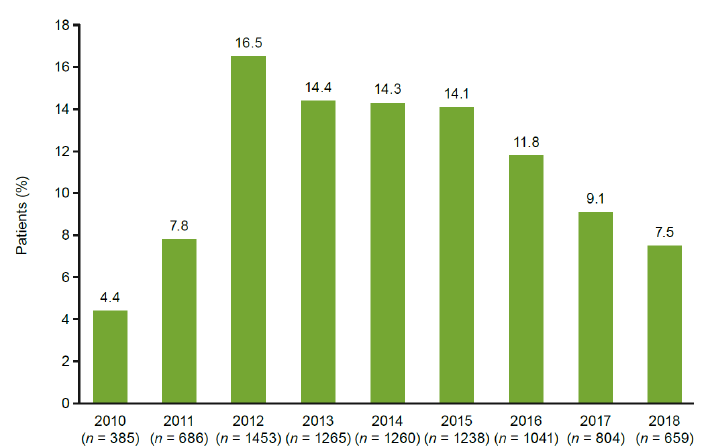
Figure 2. Patients with index diagnosis during each study year. Table 2. Clinical characteristics and treatment management over the study period *.